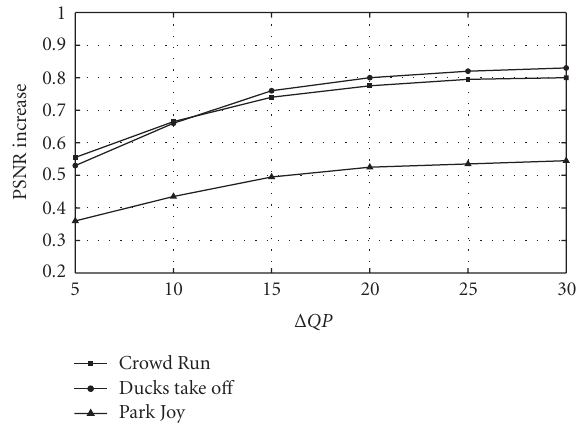
Figure 12: Quality improvement due to ROI introduction for the Park Joy , Ducks take o ff , and Crowd Run video sequences.